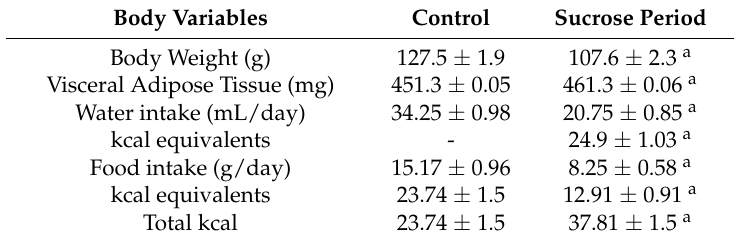
Table 1. Body variables and food and water intake in control and sucrose period rats (SP).